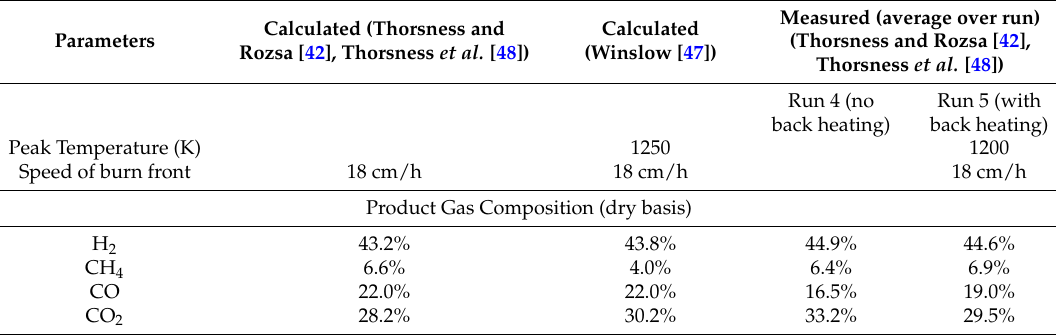
Table 7. Steady-state temperature and major constituents of outlet gas